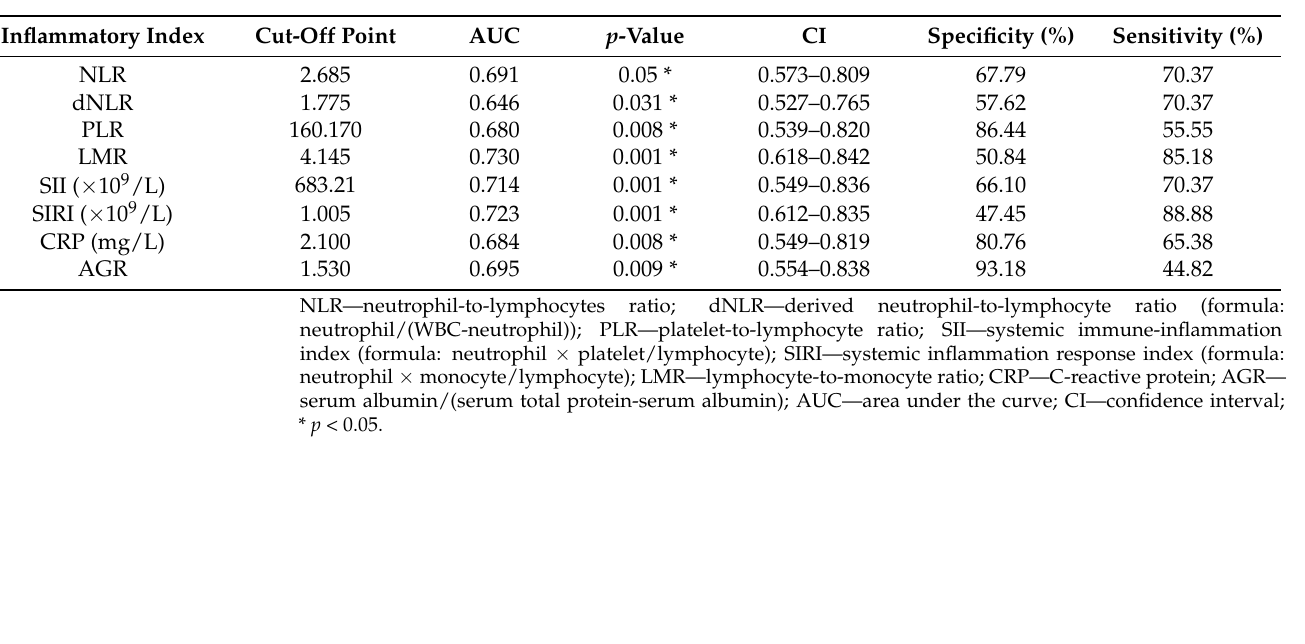
Table 3. Receiver operating characteristics (ROC) curve analysis for pre-orchiectomy inflammatory indices’ performance in predicting metastatic disease among patients diagnosed with testicular